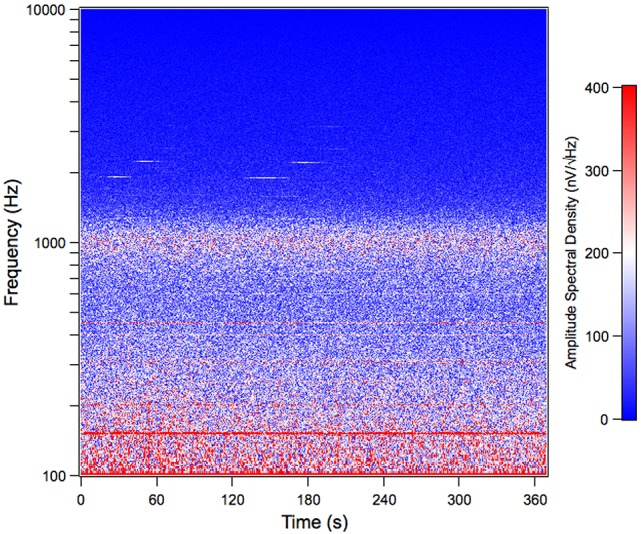
Time spectrum of the tympanic electric noise in humans. This spectrogram shows the stability of the 1,000 Hz peak throughout a complete session of tympanic electric noise recording (360 s) in one subject. Notice that, although the spectral peak is centered around 1,000 Hz, at the single epoch level (each dot in the time spectrum), varies between 800 Hz and 1,200 Hz. This figure shows data before the denoise procedure. The subject corresponds to the volunteer with the largest peak at 1,000 Hz in Figure 1.